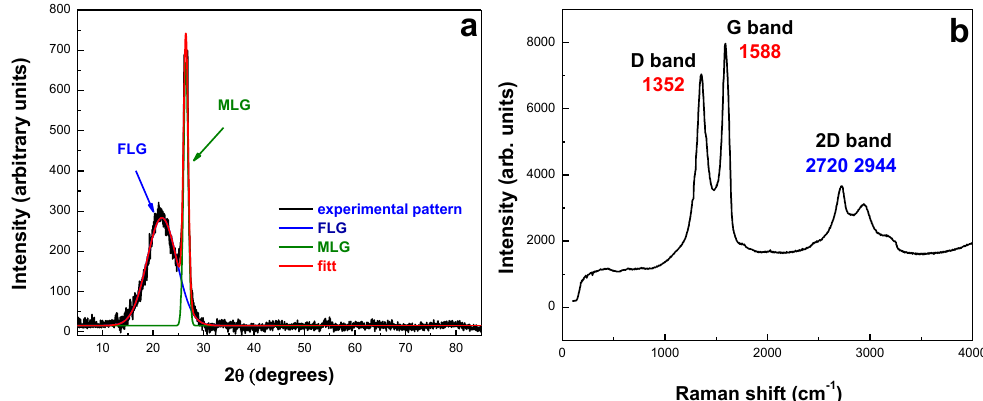
and MLG (23.57%), respectively.